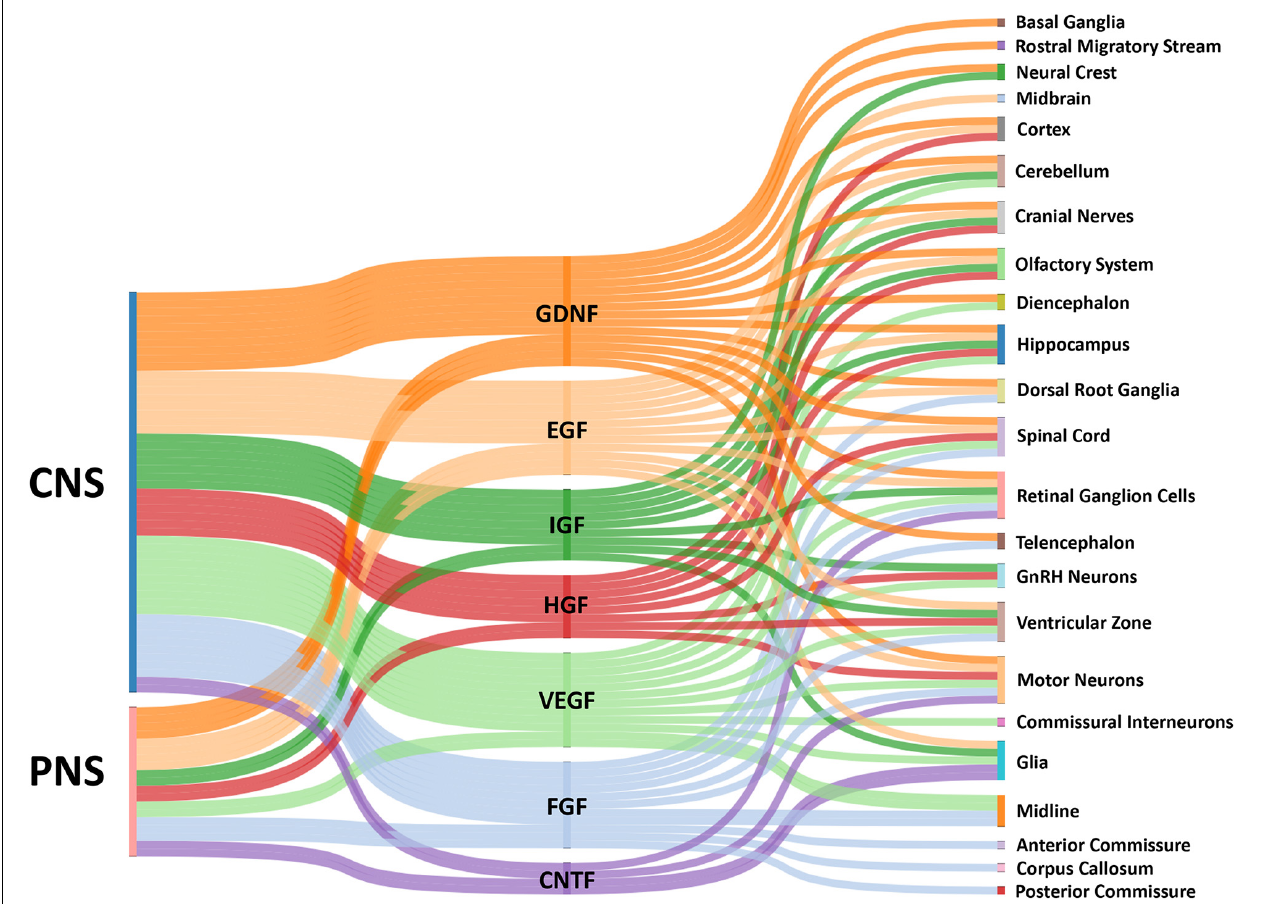
FIGURE 1 | Sankey diagram illustrating influence of growth factors across the CNS and PNS. The colored bars indicate where expression of a growth factor has been identified in either the CNS or PNS in vivo . Multiple bars from a single growth factor to a single target implies input from both the CNS and PNS. The localization of growth factors in particular combinations provides complex influences on growth cones for the assembly of the nervous systems by providing temporal-spatial cues for axon